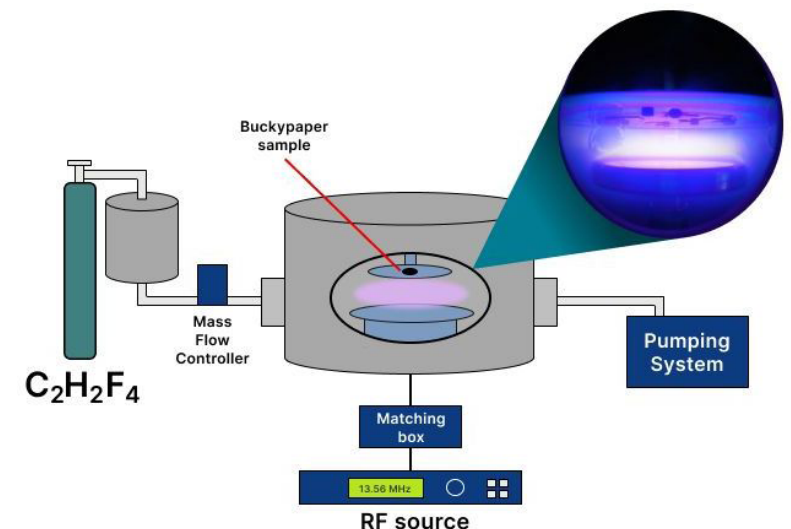
Figure 2. Schematic representation of the RF-PECVD system used for the plasma treatment of buckypapers and a detail picture of the plasma.